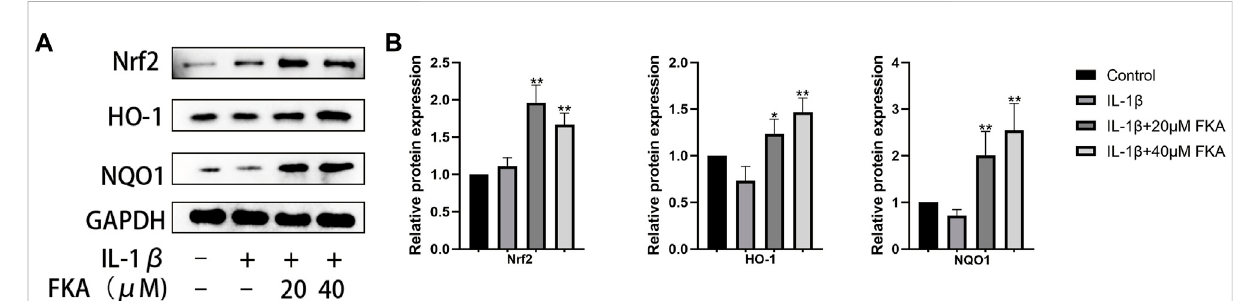
FIGURE 6 FKAalters antioxidantgeneexpressioninchondrocytes (A) WesternblotassayrevealingNrf2,HO-1, andNQO1expressioninchondrocytes.